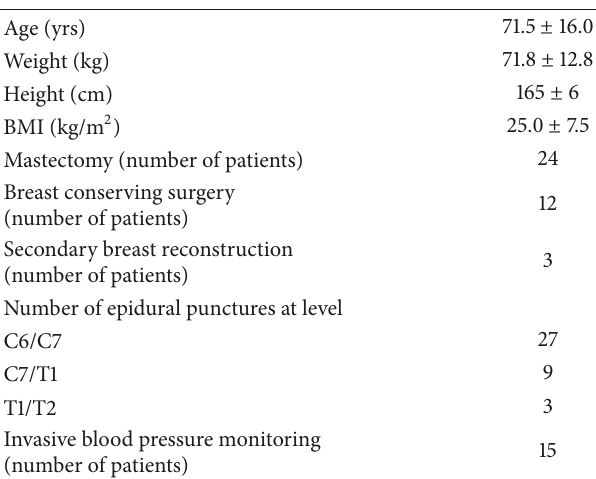
Table 1: Demographic